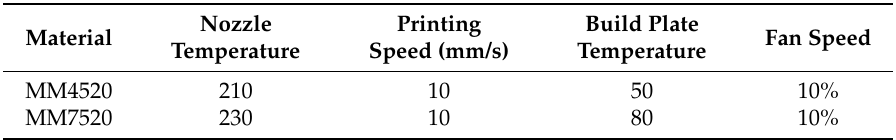
Table 1. Printing parameters used when 3D printing with each respective material (MM4520 and